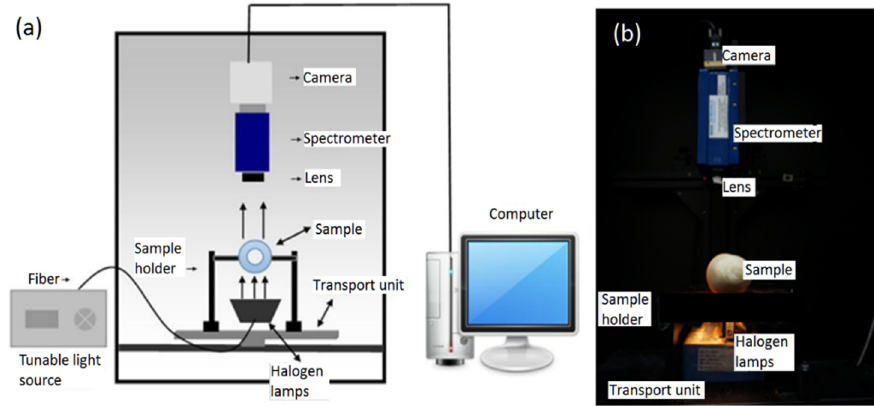
Figure 2. Hyperspectral imaging system. ( a ) schematic diagram; ( b ) physical map.